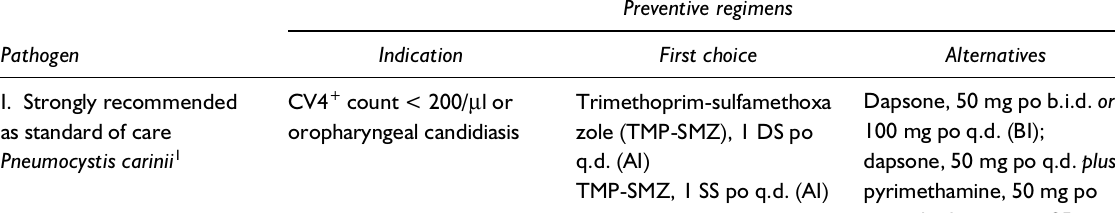
Table 2 Prophylaxis to prevent first episode of opportunistic disease in adults and adolescents infected with human immunodeficiency